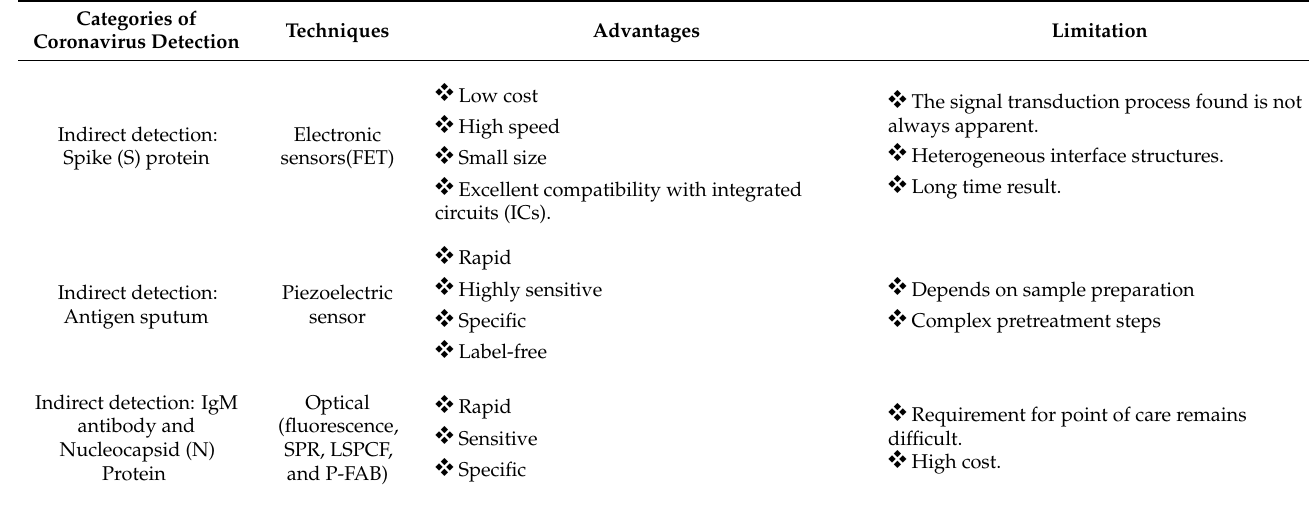
Table 5. COVID-19 detection techniques advantages and limitations comparison.